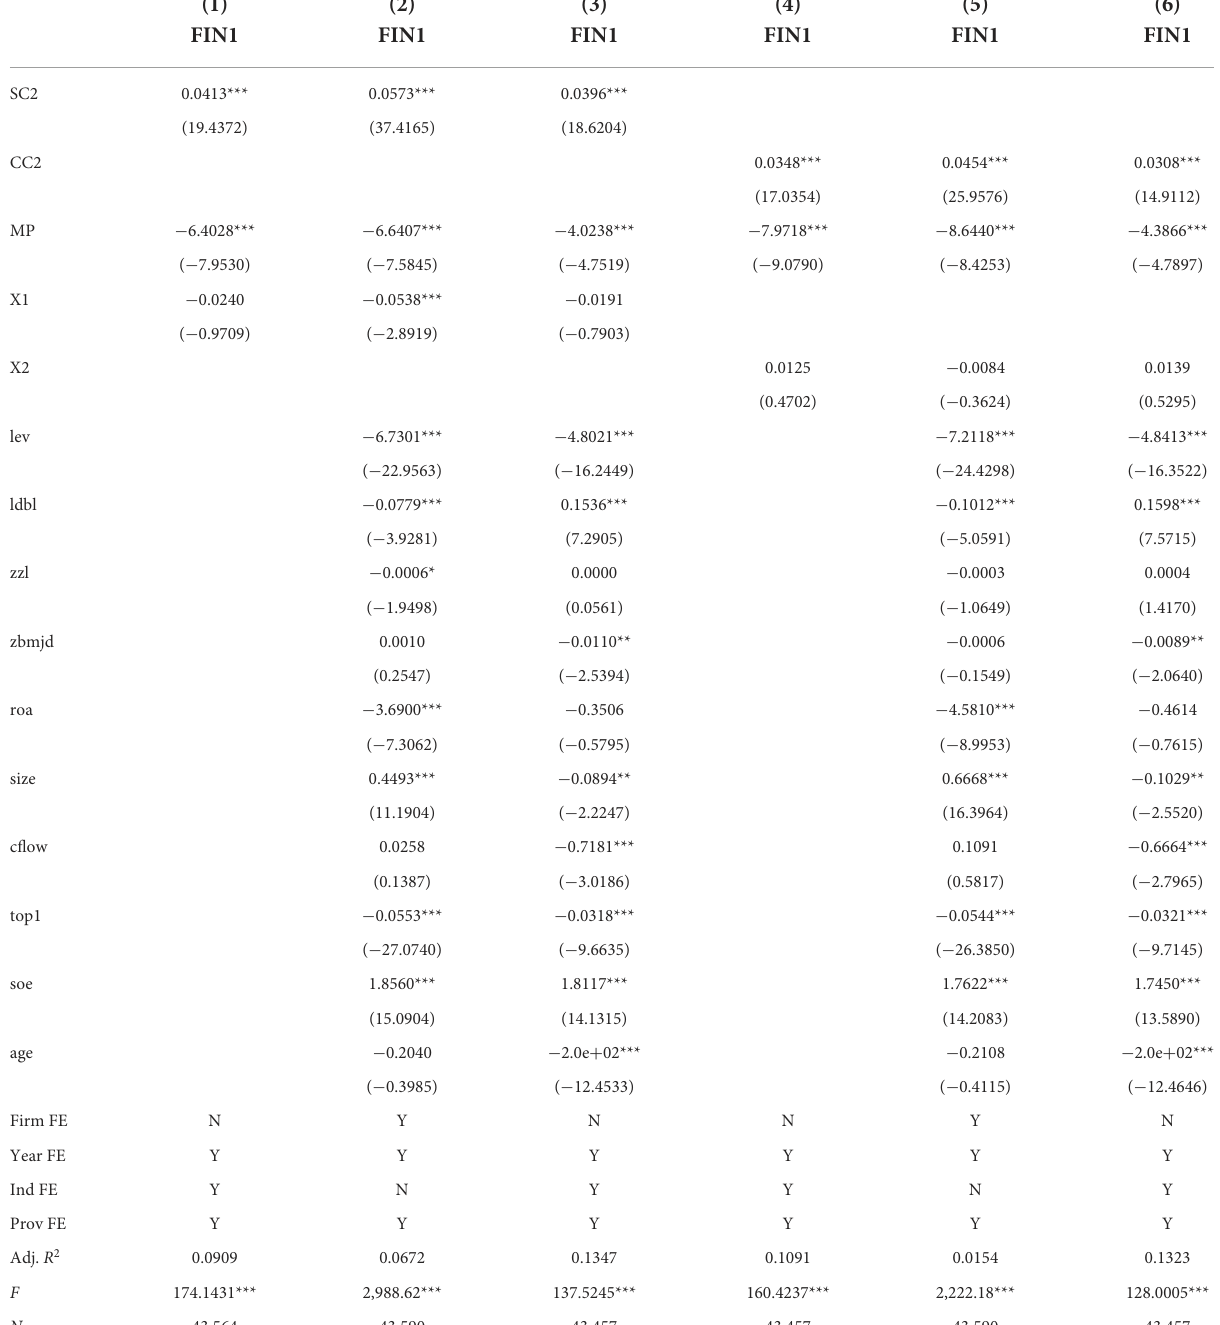
TABLE 4 Supply chain concentration, competitive power, and